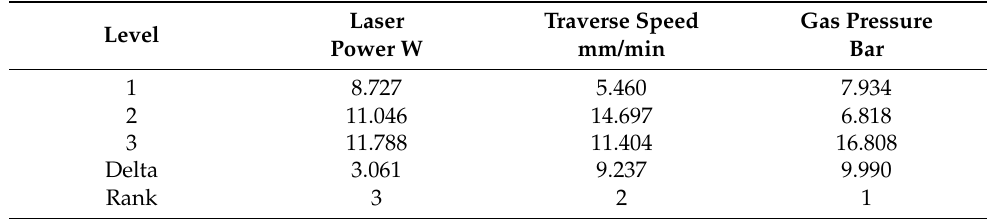
Table 8. S/N ratio response table of input cutting parameters of the 2 mm thickness off SPF-UPE composite cut by laser beam cutting process.